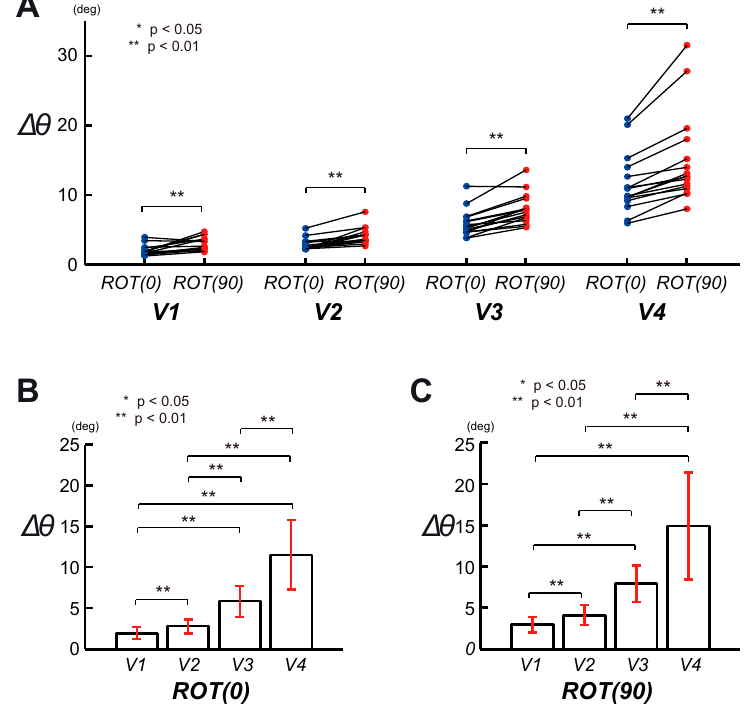
Figure 4. Evaluation of the circular tracking movement based on ∆ θ in 3D VR space. ( A ) The graphs indicate the pairwise comparison of ∆ θ analyzing the speed factor between ROT (0) and ROT (90). ( B ) The result of the pairwise comparison was indicated for ∆ θ , on the frontal plane ( ROT (0)), at four target speeds. ( C ) The pairwise comparison was displayed for ∆ θ , on the sagittal plane ( ROT (90)), at four target